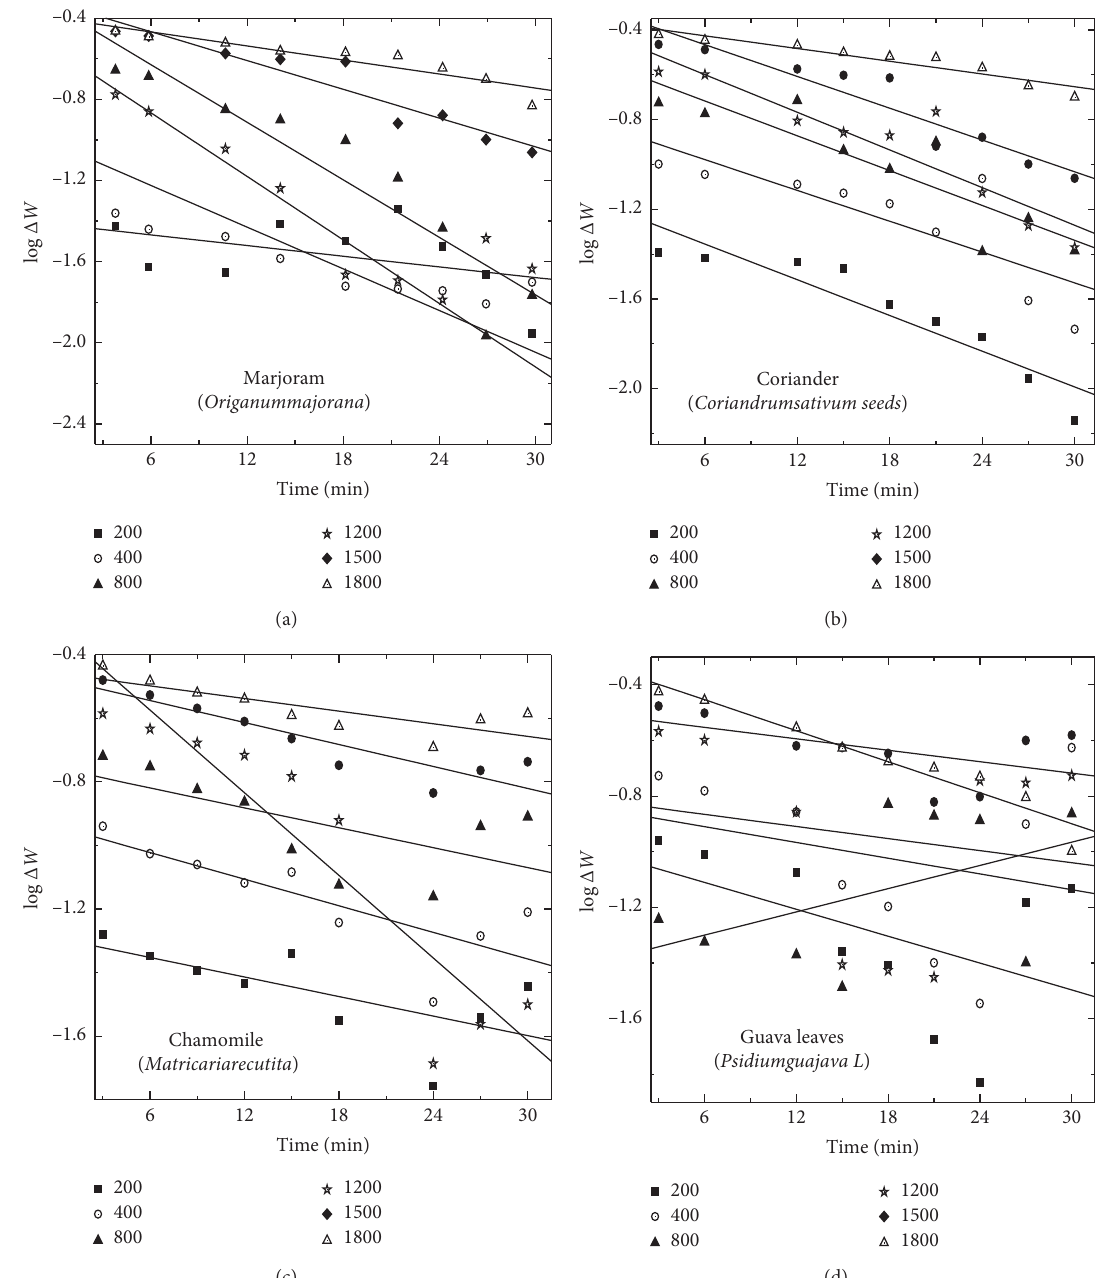
Figure 7: Variation of weight loss with time for mild steel (of a cross sectional area of 10cm 2 ) in 8M H3PO4 solutions containing methanolic extract: (a) marjoram, (b) coriander seeds, (c) chamomile, and (d) guava leaves at 25 ° C. Table 3: Rate constant and half-life time values for mild steel coupons in 8.0M H methanolic plant extract using the weight loss technique. Methanolic extract